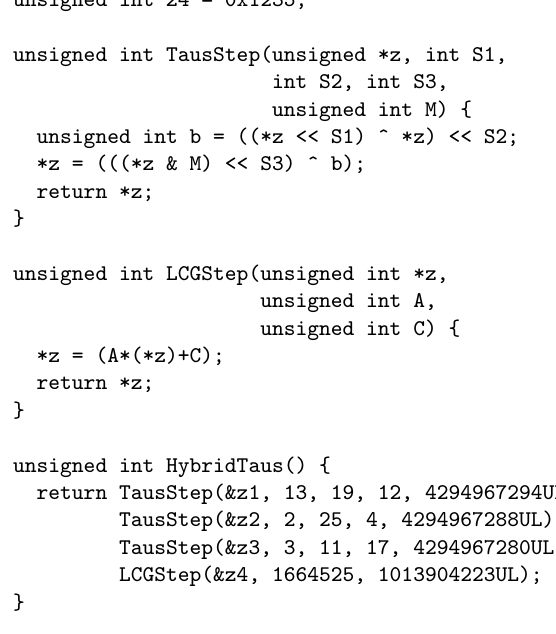
Figure 3: The hybrid Tausworthe generator used to create seed values for the GPU. This code was run on the CPU and very quickly generated a vector of 32- bit integer seed values, one for each particle of each swarm. The variable z4 is the seed for the linear congruential step and was used as the seed for the entire